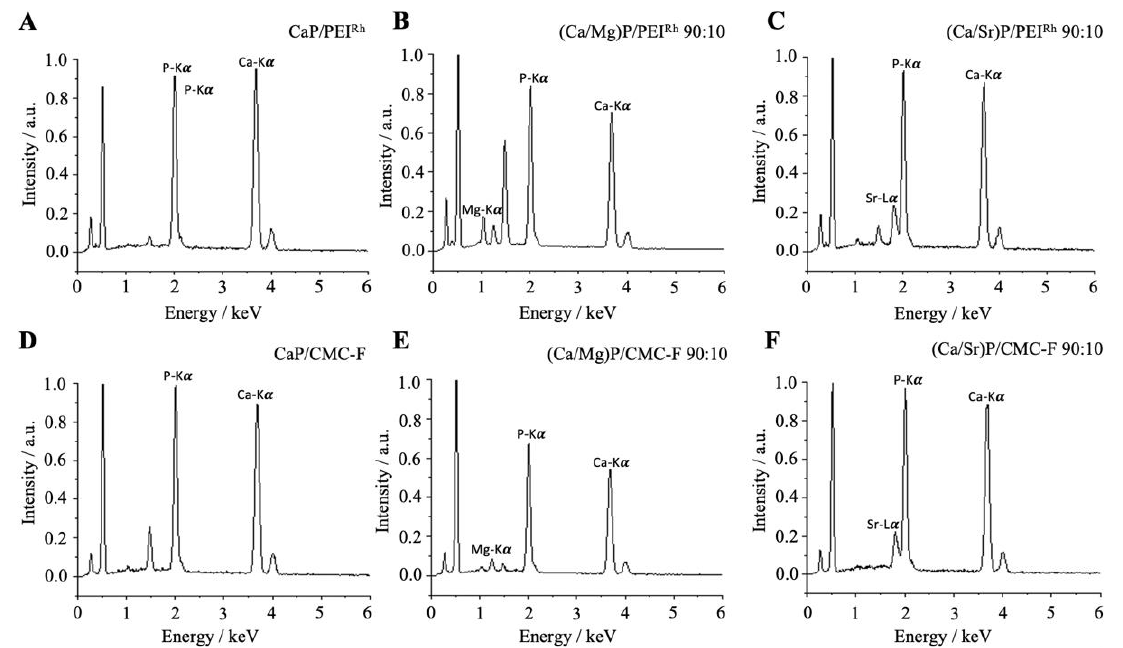
Figure 4. Representative energy-dispersive X-ray spectra (EDX) of calcium phosphate nanoparticles ( A , D ), magnesium-doped calcium phosphate nanoparticles ( B , E ); and strontium-doped calcium phosphate nanoparticles ( C , F ).